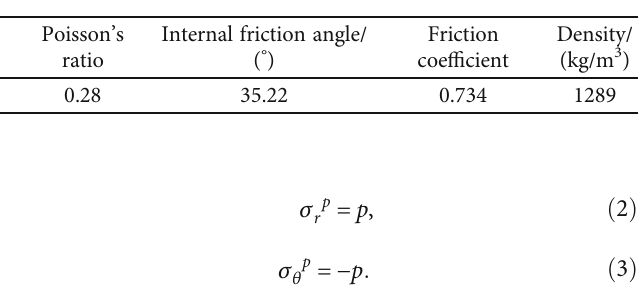
Table 1: Basic physical and mechanical parameters of coal and